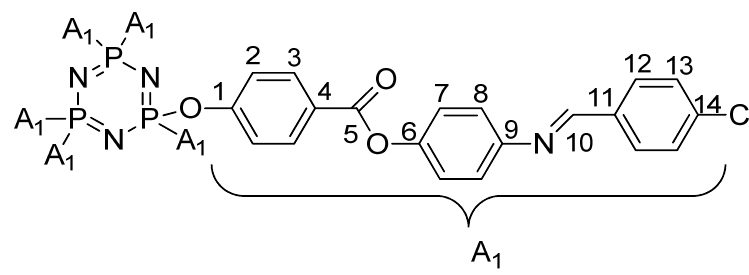
Figure 2. Chemical structure of compound 4a with complete atomic numbering.